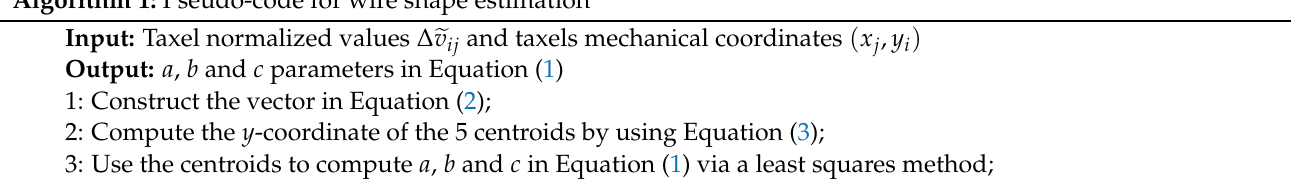
Algorithm 1: Pseudo-code for wire shape